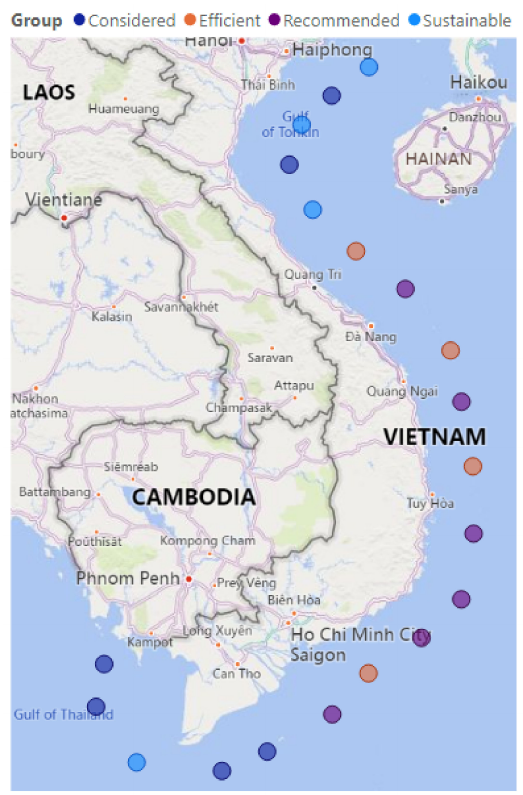
Figure 9. Recommended locations for WWS in